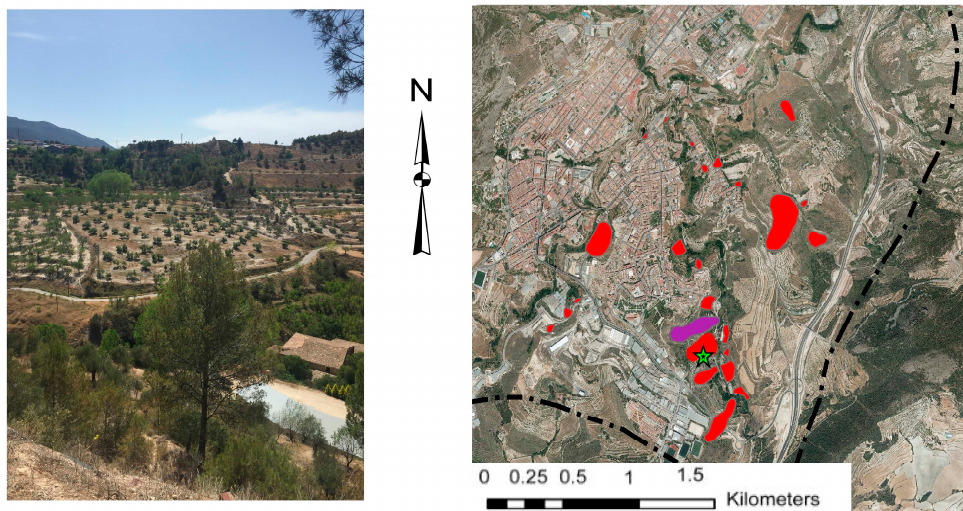
Figure 8. ( a ) Example of landslide surveyed in the Alcoy urban area; ( b ) aerial photo of the Alcoy urban area (Instituto Cartográfico Valenciano 2017, http://www.icv.gva.es/ca/inicio) with the inventoried landslides (red zones). The green star locates the photo-view, the violet color indicates the Molinar landslide.